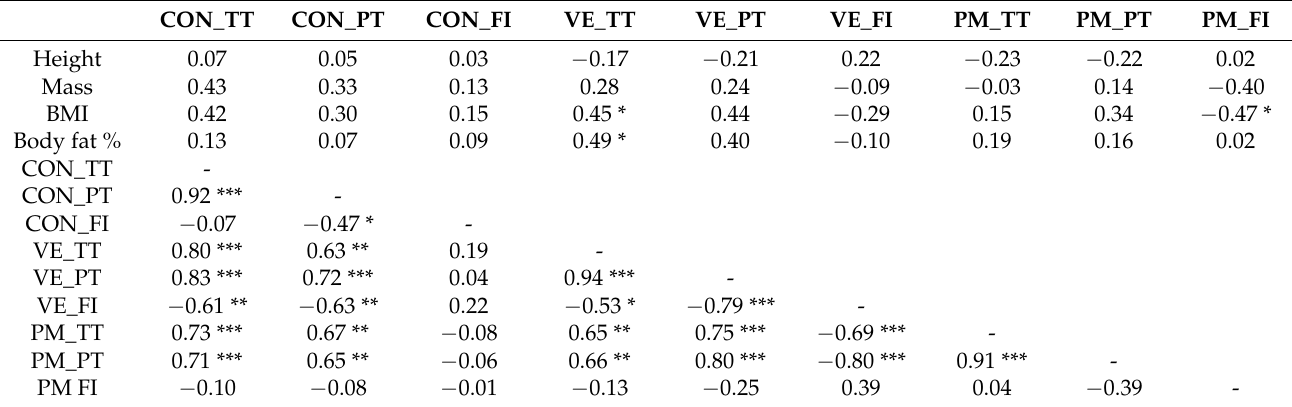
Table 3. Pearson’s correlations between study